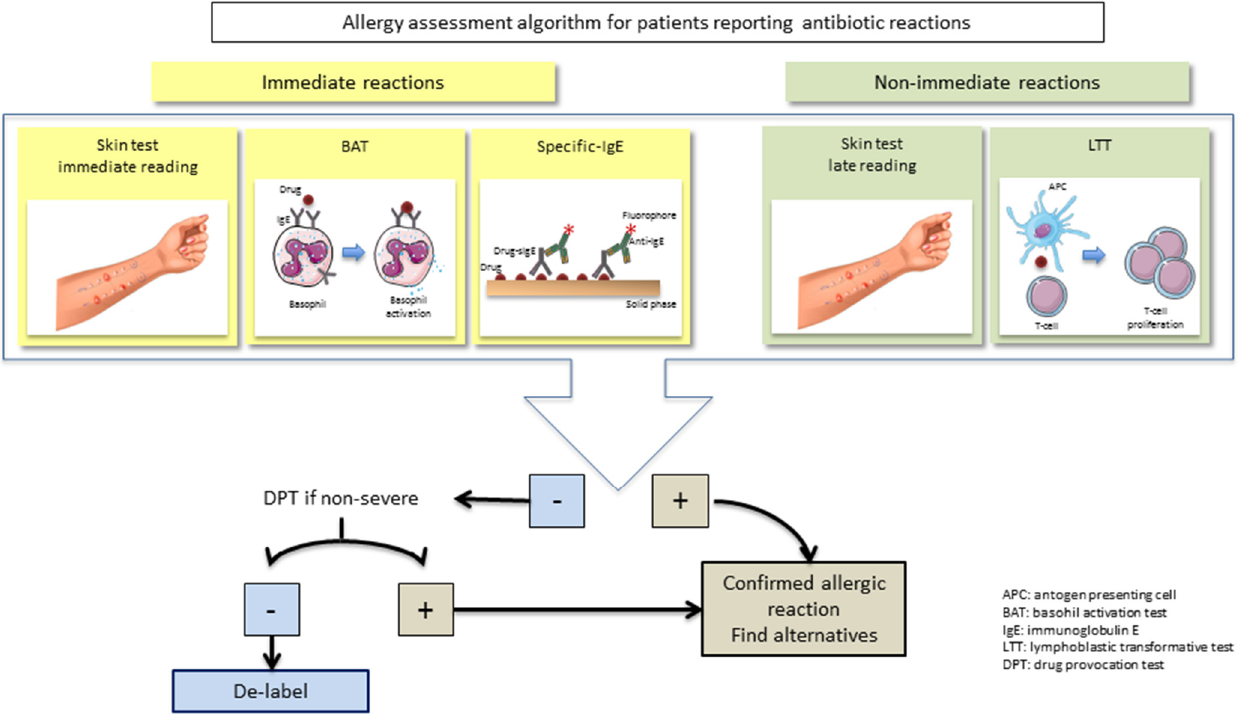
Figure 2. Algorithm for evaluating suspicion of allergic reactions to antibiotics.